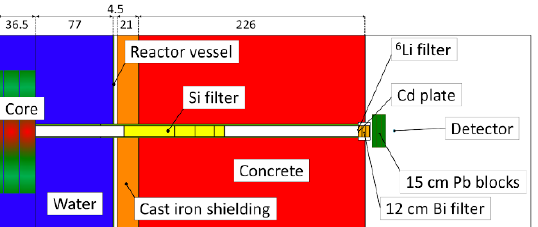
Fig. 2. The experimental arrangement in the reactor laboratory. The detectors were placed along the beam axis at 1.5 m distance from the silicon filter target [1].